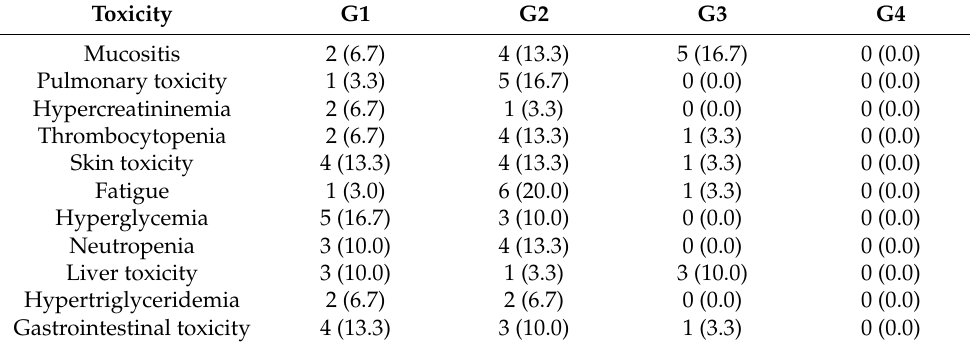
Table 5. Evaluation of